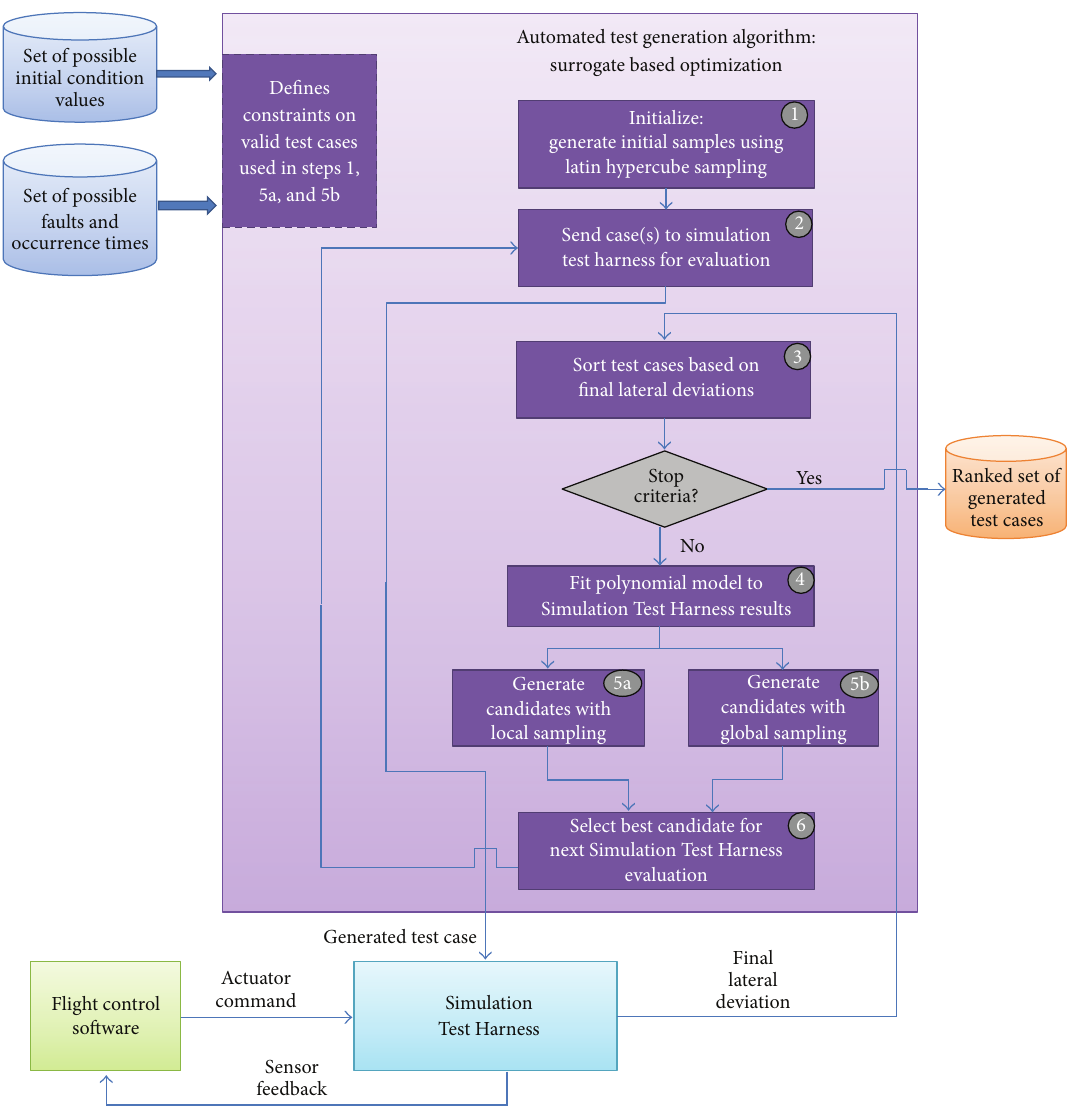
Figure 8: Flowchart of the surrogate-based optimization automated test generation